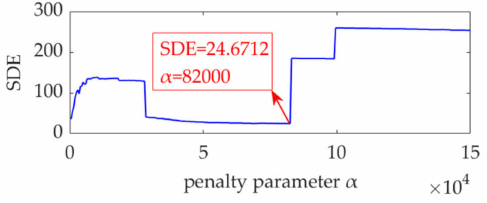
Figure 3. Relationship between the SDE index and penalty parameter α